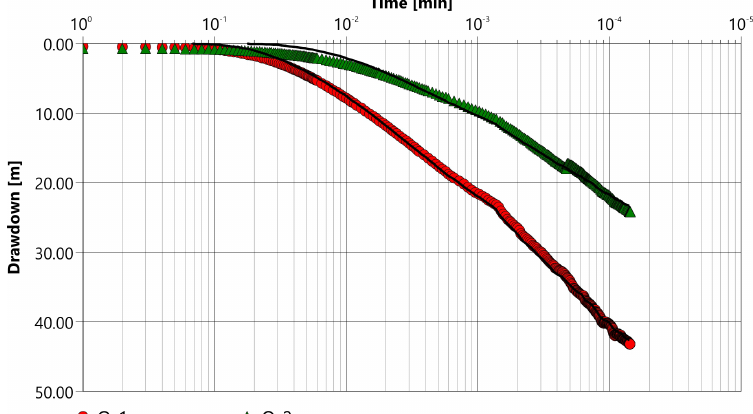
Figure 7. Analytical diagram for measurements in O-1 and O-2 during the first step of the pumping test (Theis